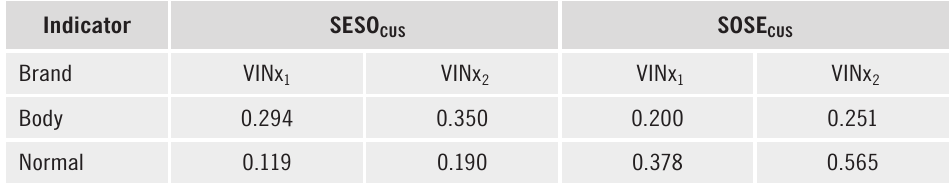
Table 6. Summary of SESO and SOSE indicators for 2013−2018 in the studied